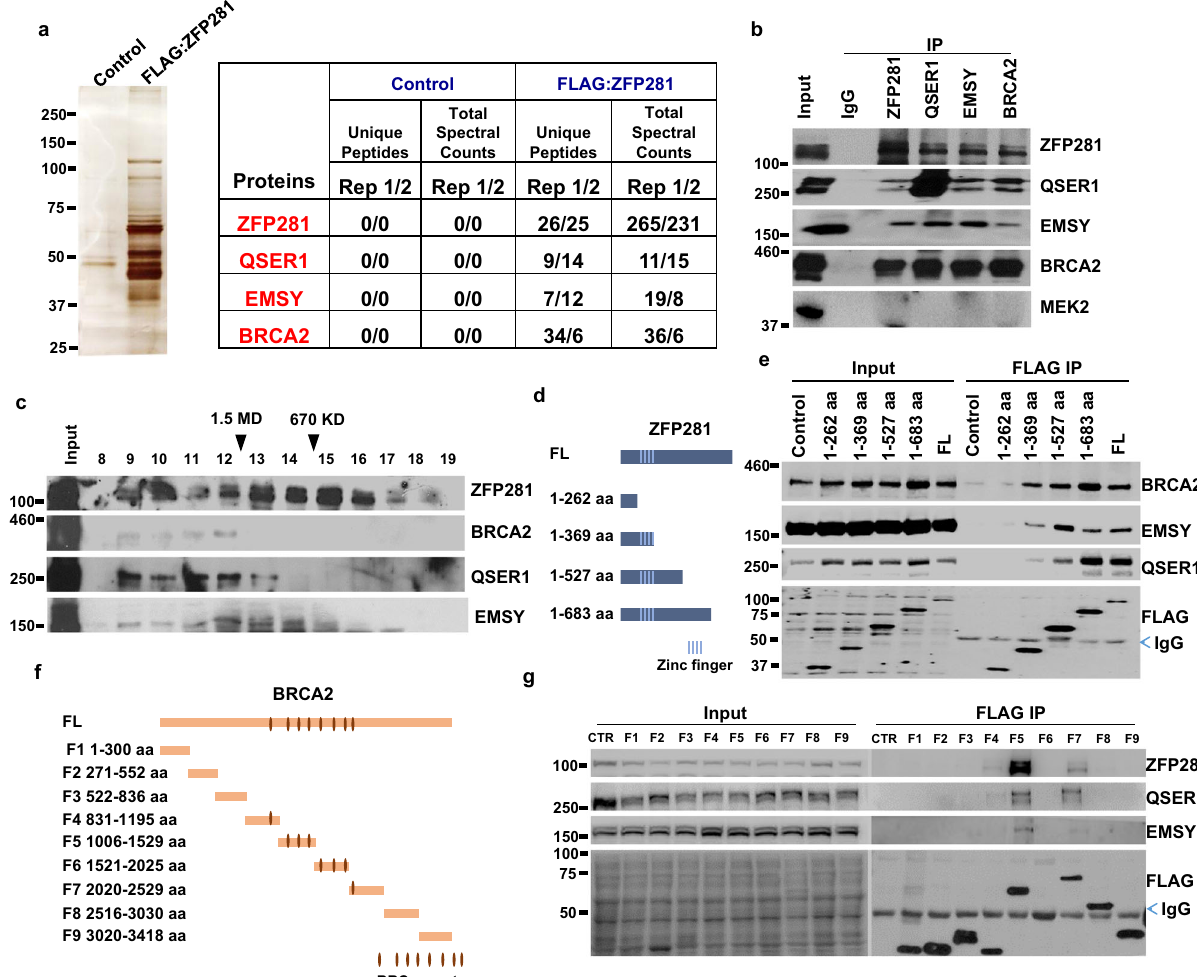
Fig. 4 ZFP281 interacts with BRCA2. a Puri fi cation and mass spectrometry analyses of the ZFP281-associated proteins. Clonal cell lines expressing FLAG- tagged ZFP281 were generated in 293 Flp-in-TRex cells and the ZFP281 associated proteins were puri fi ed using the FLAG-af fi nity puri fi cation method and analyzed by SDS-PAGE, silver staining and mass spectrometry. At least two independent biological repeats with similar results. b Con fi rmation of the interaction of ZFP281 with EMSY, BRCA2, and QSER1 by endogenous immunoprecipitations. c Size exclusion chromatography of ES nuclear extracts demonstrated that the ZFP281, BRCA2, EMSY and QSER1 co-elute at ~ 2 MDa (fractions 9 – 12). d , e Different ZFP281 truncated proteins were expressed with an N-terminal FLAG tag in 293 T cells, and the interactions of BRCA2, EMSY, QSER1 with these ZFP281 truncated proteins were examined by FLAG immunoprecipitations, followed by western blot analyses. f , g Different BRCA2 truncated proteins were expressed with an N-terminal FLAG tag in 293 T cells, and the interactions of ZFP281, EMSY, QSER1 with these BRCA2 truncated proteins were examined by FLAG immunoprecipitations, followed by western blot analyses. At least three biological replicates were performed in b , c , e and g with similar FLAG-ZFP281 puri fi cation products. In addition, we found here that the BRC repeat domain is also essential for the interaction of BRCA2 with ZFP281. Thus, we postulated that ZFP281 and RAD51 might be mutually exclusive in interacting with BRCA2.